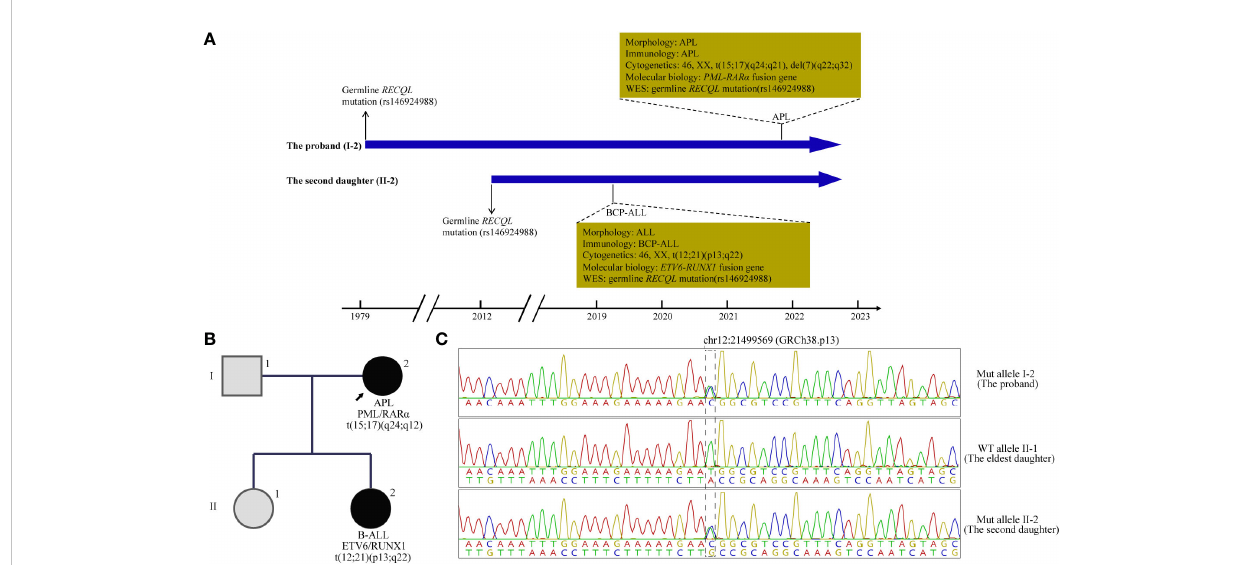
FIGURE 1 A brief summary of medical history and pedigree for the RECQL mutation carriers. (A) Timeline of clinical events in 2 patients with acute leukemia. (B) The Pedigree and germline and tumor chromatopherogram con fi rmed the presence of single nucleotide variation in RECQL (rs146924988) in 2 patients with acute leukemia in this family, while it was negative in healthy members. (C) Sanger sequencing of nasopharyngeal swab specimens was used to verify RECQL mutation (rs146924988) in the proband and her two daughters. APL, acute promyelocytic leukemia; WES, whole exome